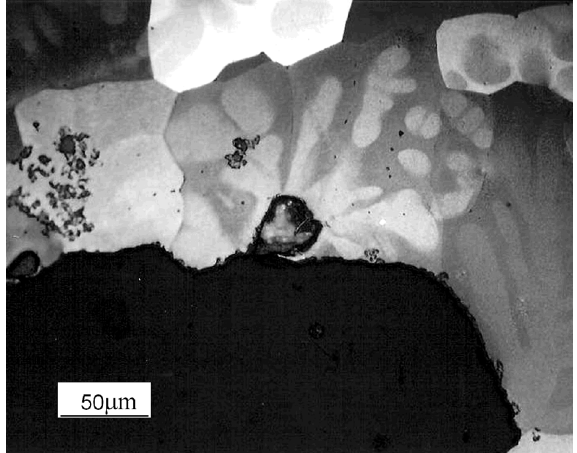
Figure 6. An optical micrograph showing oxide clusters close to cell wall surfaces.